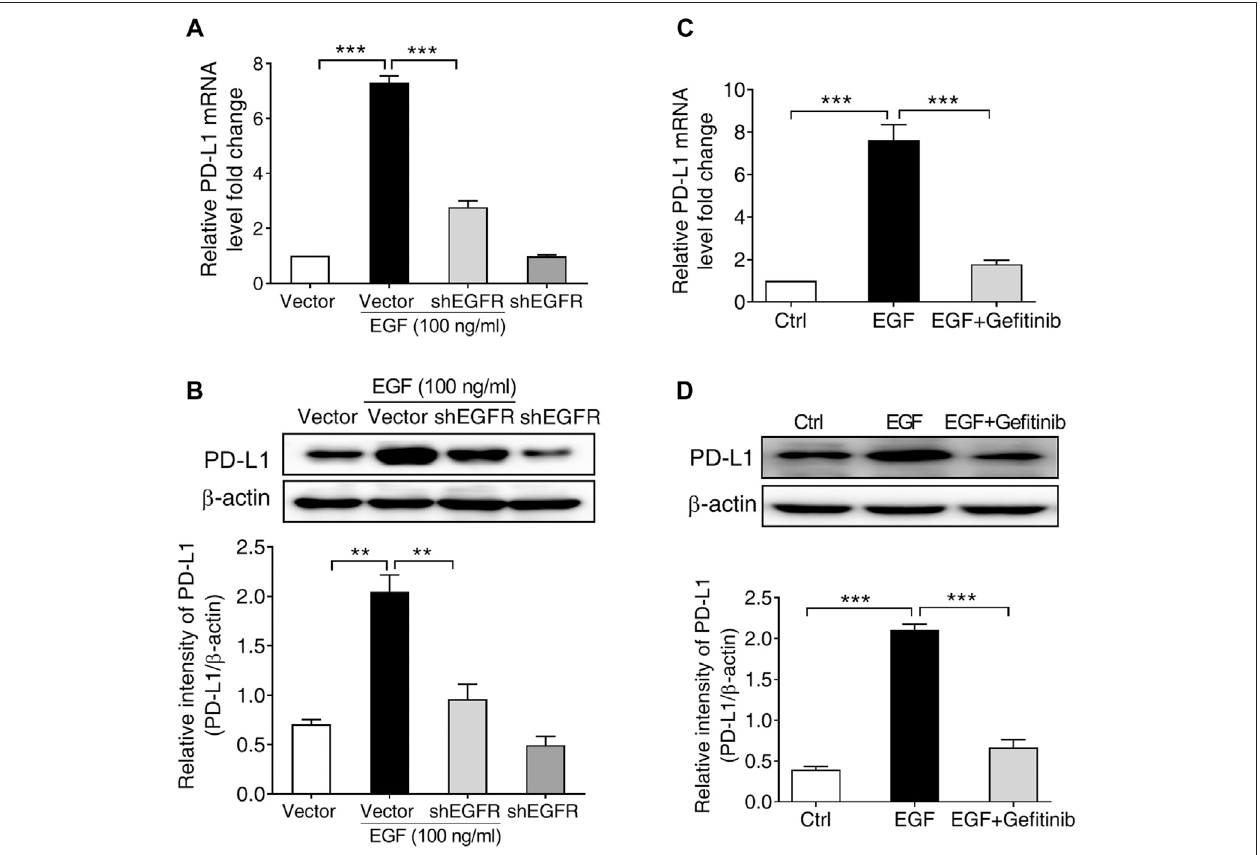
FIGURE 2 | EGFR activation is required for PD-L1 expression in SNU-368 cells. (A,B) Knockdown of EGFR with speci fi c shRNA reversed EGF-induced PD-L1 mRNA (A) andprotein (B) expressionsinSNU-368cells.At24 hpost-transfection,thecellswereincubatedinthepresenceorabsenceof100 ng/mlEGFfor12 h.** p < 0.01, *** p < 0.001, one-way ANOVA, n (cid:2) 4 independent experiments per group. (C,D) EGF-induced upregulation of PD-L1 mRNA (C) and protein (D) was blocked by ge fi tinib. *** p < 0.001, one-way ANOVA, n (cid:2) 5 independent experiments per